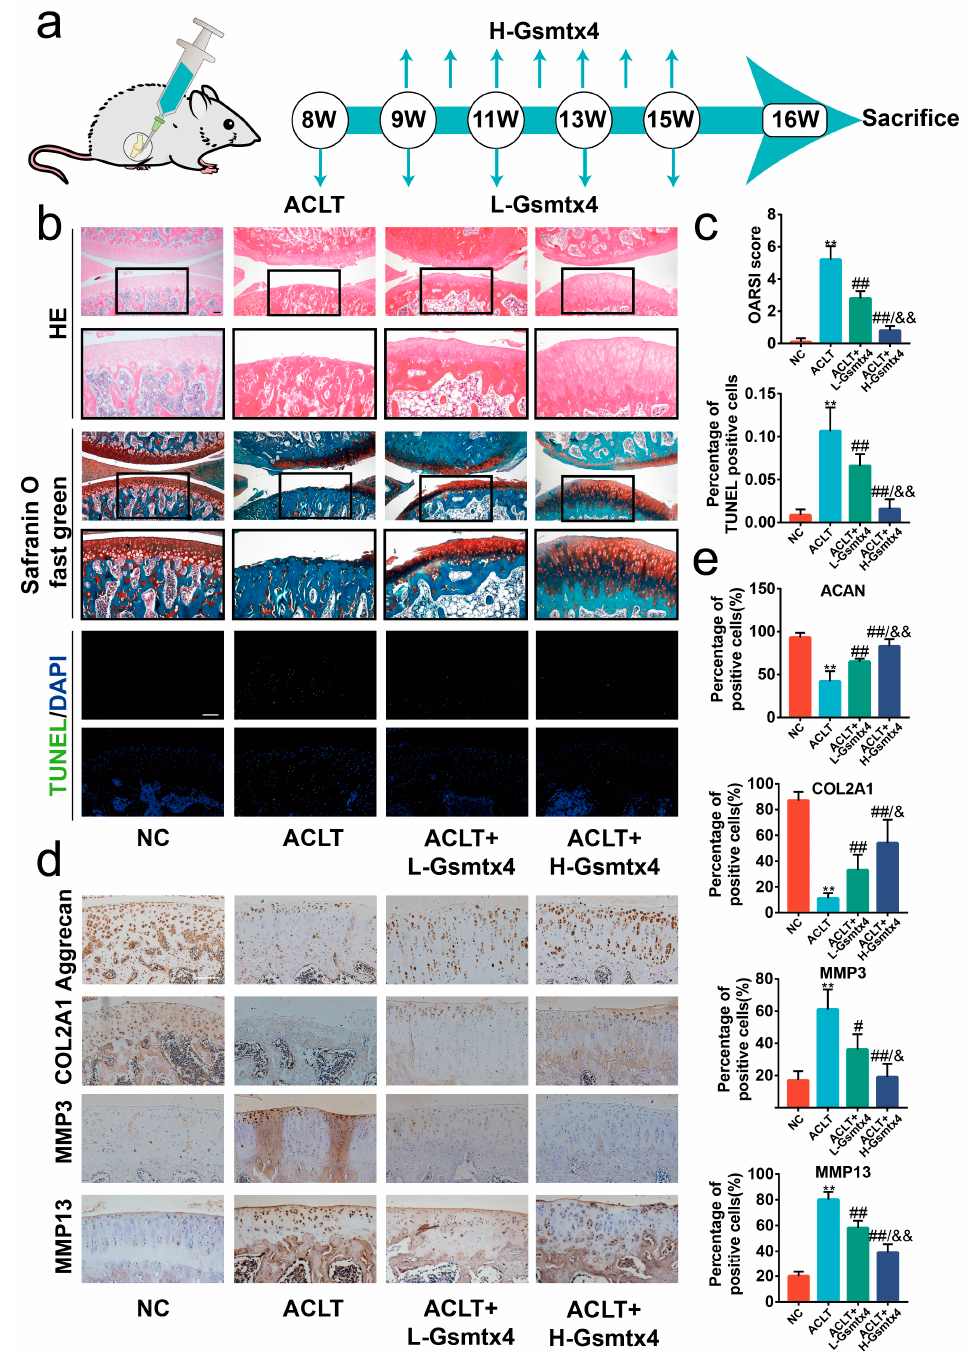
Figure 7. Intra-articular injections of Gsmtx4 ameliorated OA in rats. ( a ) Schematic illustration of Gsmtx4 injection in the ACLT-induced OA rat model. ( b ) HE, Safranin-O/Fast Green, and TUNEL stains of articular cartilage ( n = 5). ( c ) The OARIS scores and the percentage of TUNEL positive cells of the cartilage ( n = 5). ( d ) Immunohistochemistry staining of Aggrecan, COL2A1, MMP3, and MMP13 in articular cartilage, and ( e ) percentage of positive cells ( n = 5). ** p < 0.01 vs. Sham; # p < 0.05 vs. ACLT; ## p < 0.01 vs. ACLT; & p < 0.05 vs. L-Gsmtx4; && p < 0.05 vs. L-Gsmtx4. One-way ANOVA with Bonferroni’s test for ( c,e ), Kruskal–Wallis test with Dunn’s multiple comparisons test for OARSI score in ( c ). Scale bar: 100 μ m.